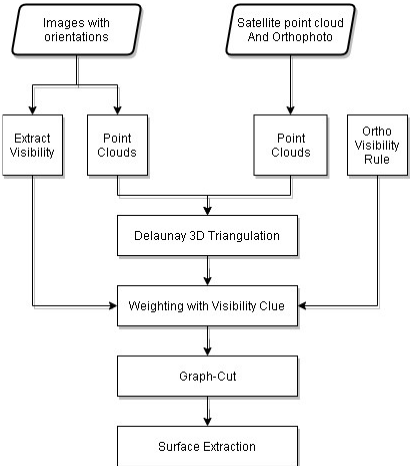
Figure 6. Our pipeline of multi-source mesh reconstruction Figure 6 shows our proposed pipeline that meshes point clouds generated from street-view images and satellite point clouds. Firstly, we form Delaunay tetrahedra with the combined